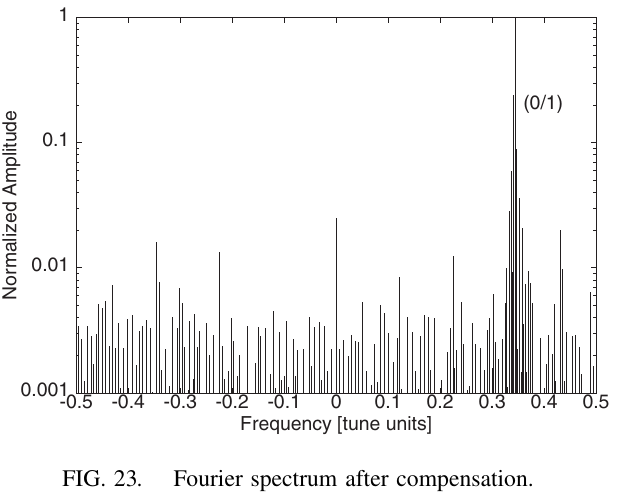
FIG. 25. Beam position.